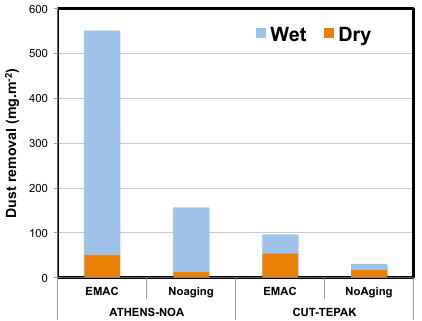
Figure 13. Sensitivity of dust removal (wet and dry) to dust aging: integrated dust removalovertheperiodfrom18 th to24 th September,2011. Figure 14. Sensitivity of dust removal (wet and dry) to dust ag- ing: integrated dust removal over the period from 18 to 24 Septem- ber